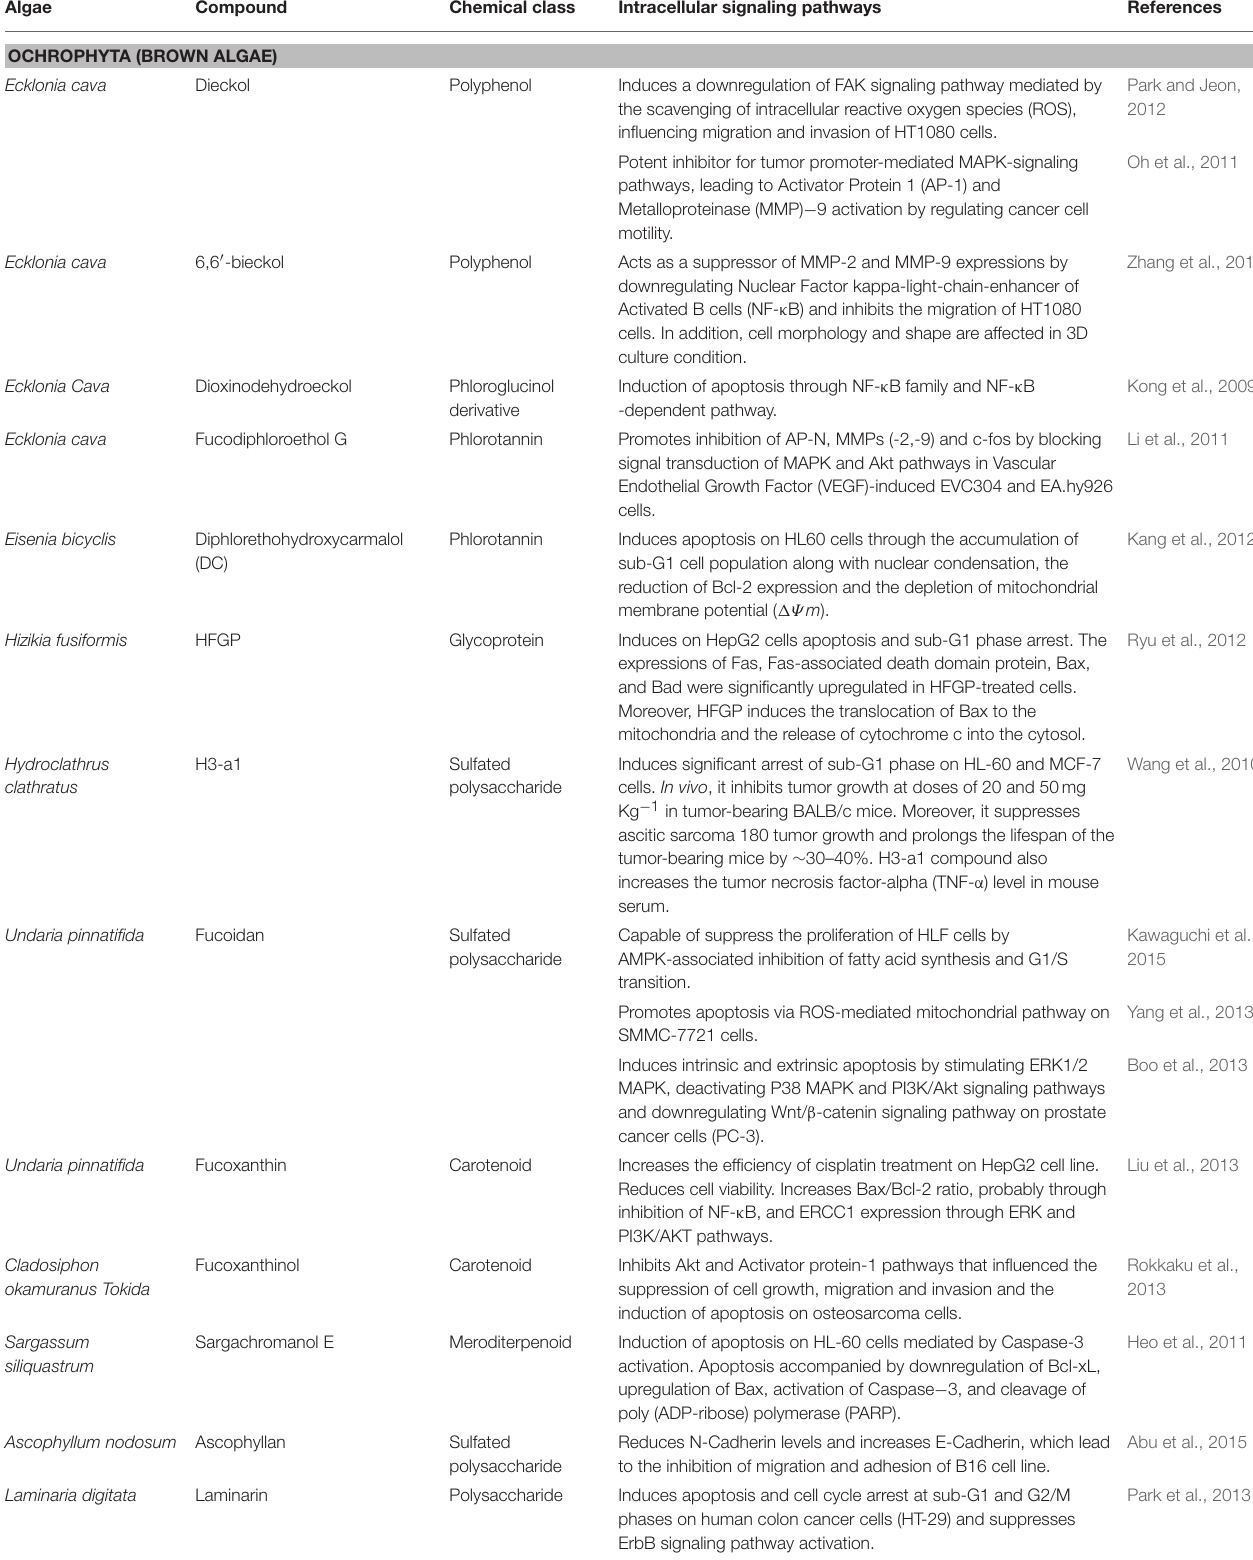
TABLE 1 | Marine compounds isolated from algae with antitumor and cytotoxic activities and intracellular signaling pathways involved.